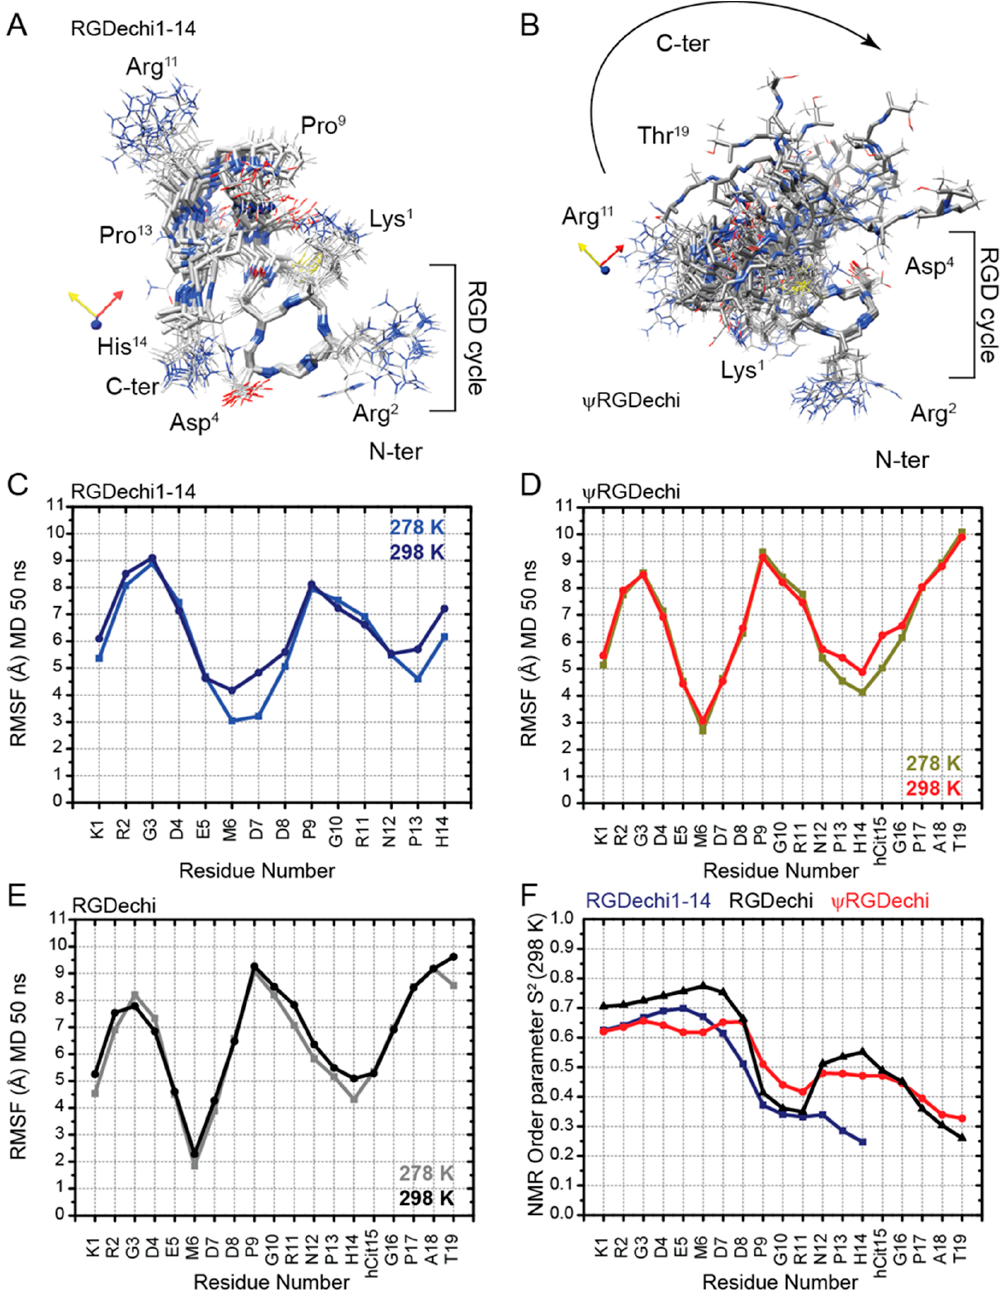
Figure 5. Picosecond to nanosecond backbone dynamics of RGDechi1-14 and ψ RGDechi. ( A , B ) RGDechi1-14 and ψ RGDechi conformational ensembles obtained after cluster analysis of the 10 ns Molecular dynamics simulation trajectories performed at 278 K. Each ensemble reports the 15 representative conformers of the most populated clusters. The conformers were aligned with respect to the RGD cycle. ( C – E ) root mean square fluctuation (RMSF) (Å) values obtained from the 50 ns MD simulations performed at 278 and 298 K for RGDechi1-14 ( C ) and ψ RGDechi ( D ) and RGDechi ( E ), respectively. ( F ) Comparison of the predicted H-N model-free order parameters (S 2 ), as reported in the materials and methods section, from backbone and C β chemical shifts for RGDechi1-14 (blue), ψ RGDechi (red), and RGDechi (black).